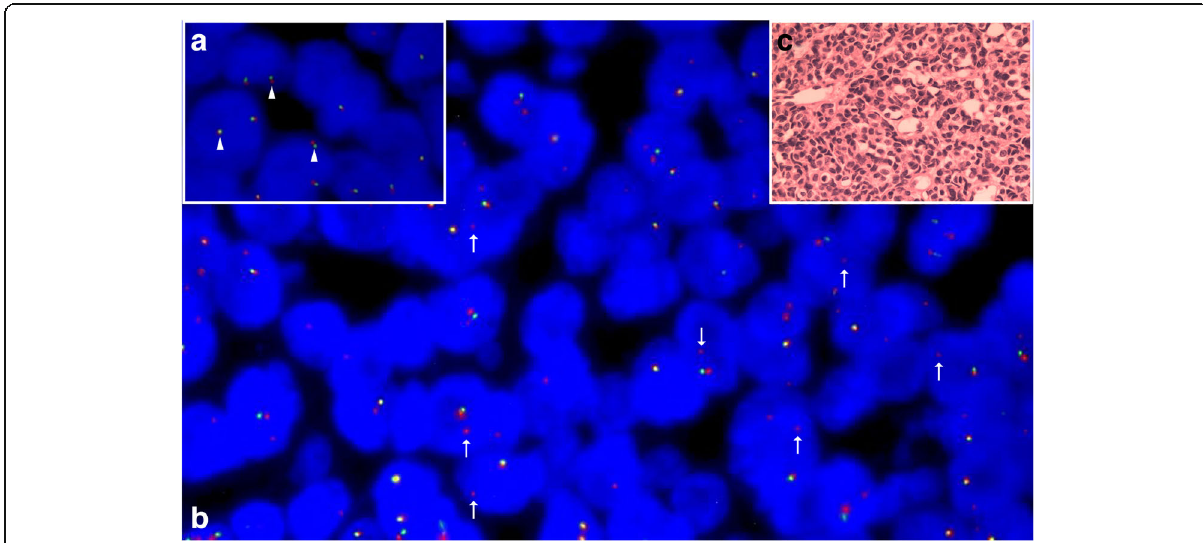
Fig. 4 Dual color ( red / green ) break-apart probe FISH test of the tumor. a Normal karyotype cells have two yellow ( red/green merged) signals ( arrowheads ). b Most tumor cells (90%) had one yellow ( red/green merged) signal and one red signal ( arrows ). C. Consecutive sections were HE-stained